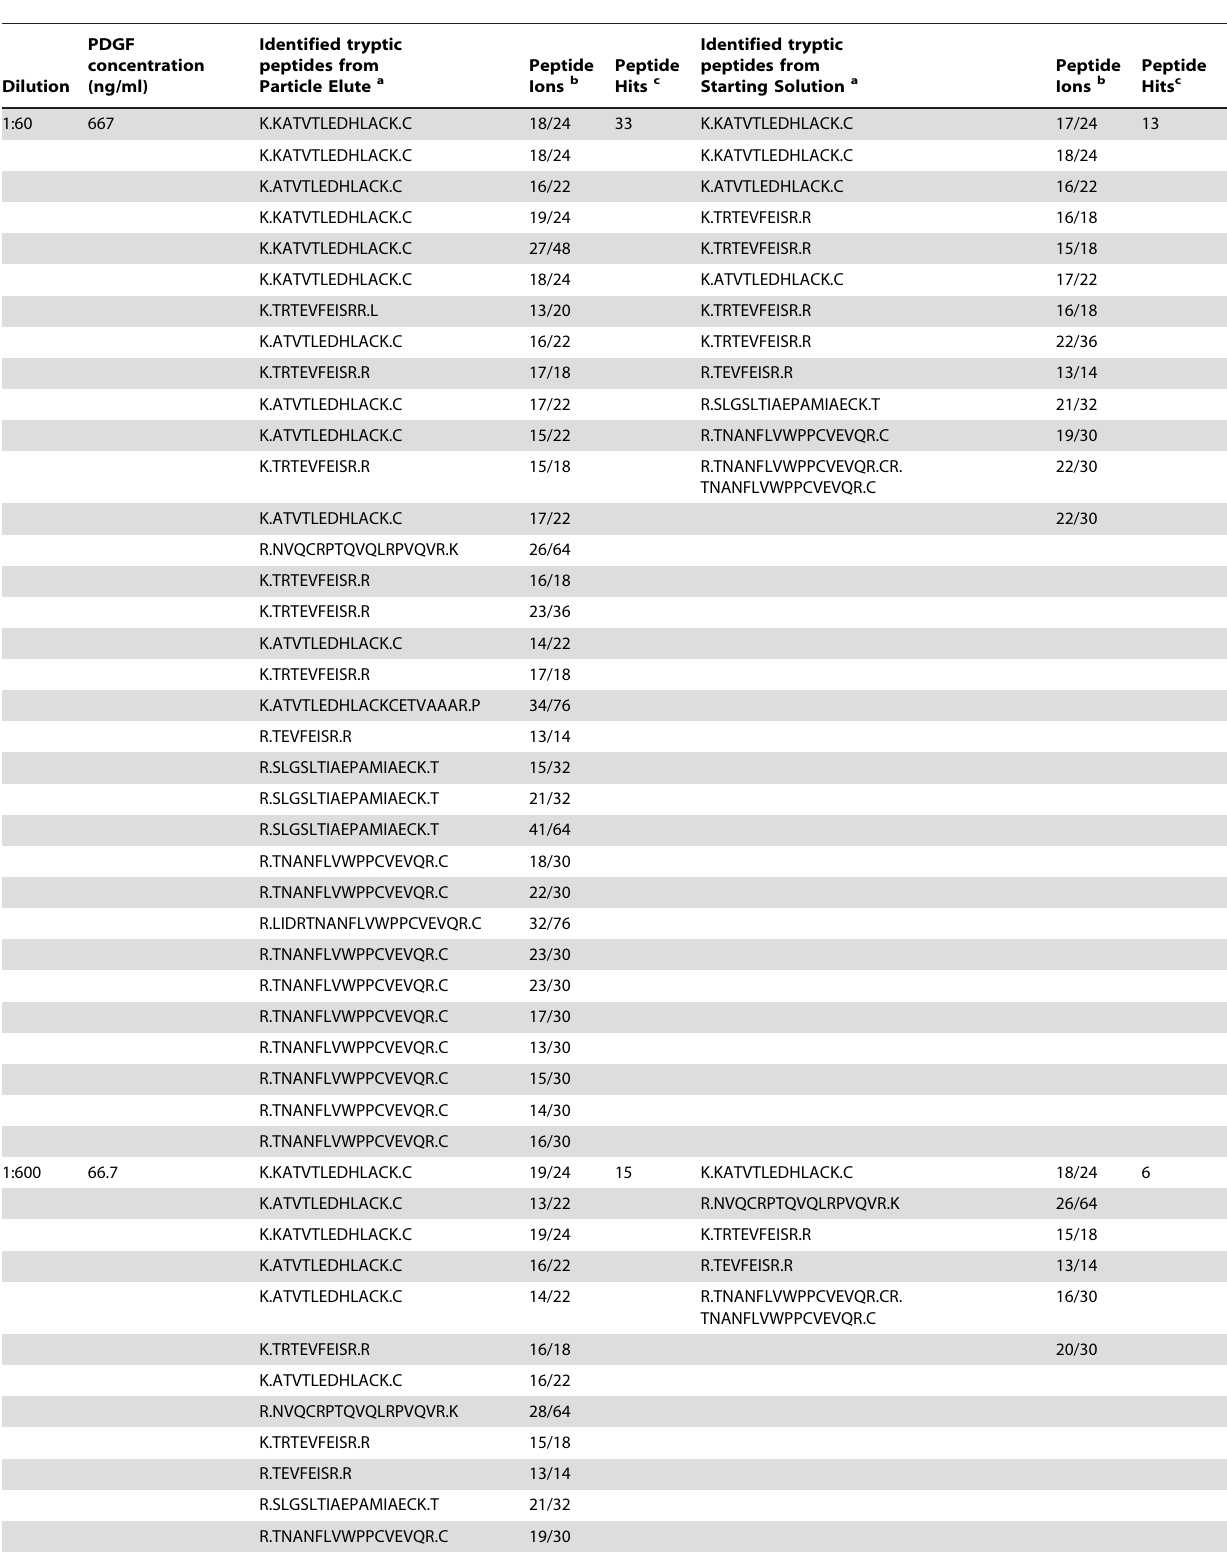
Table 1. Comparison of identified tryptic peptides from particle elute and starting solution by nano reverse phase liquid chromatography mass spectrometry (RPLC-MS/MS).